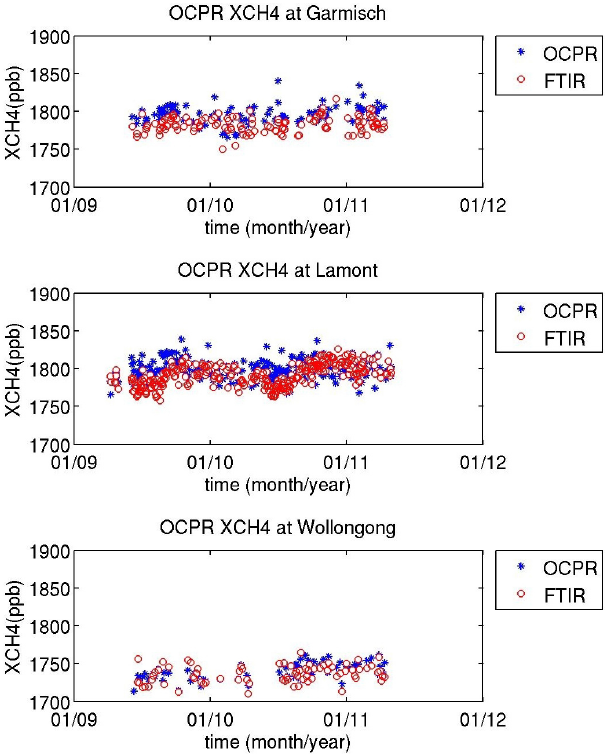
Figure 14. Daily averaged time series of paired OCFP and TC- CON FTIR XCH4 at Garmisch (top), Lamont (mid) and Wollon- gong